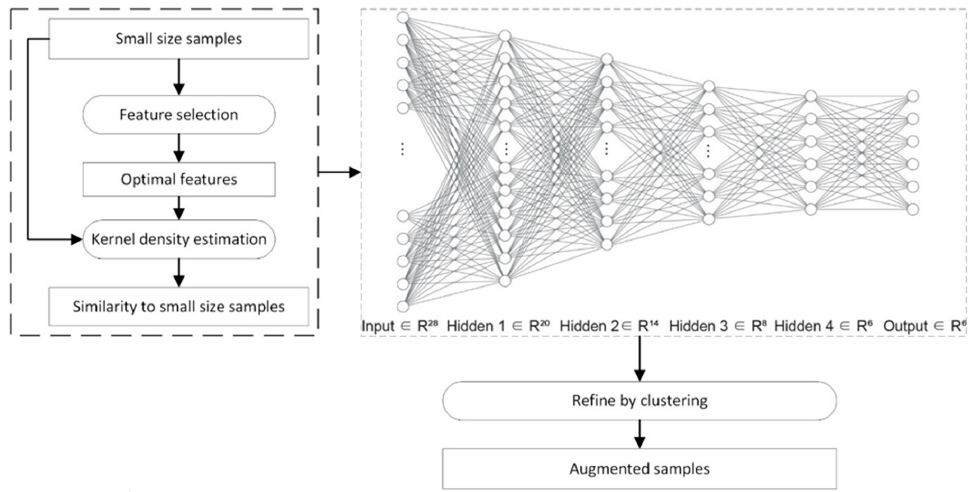
Figure 2. Workflow of sample augment by the proposed